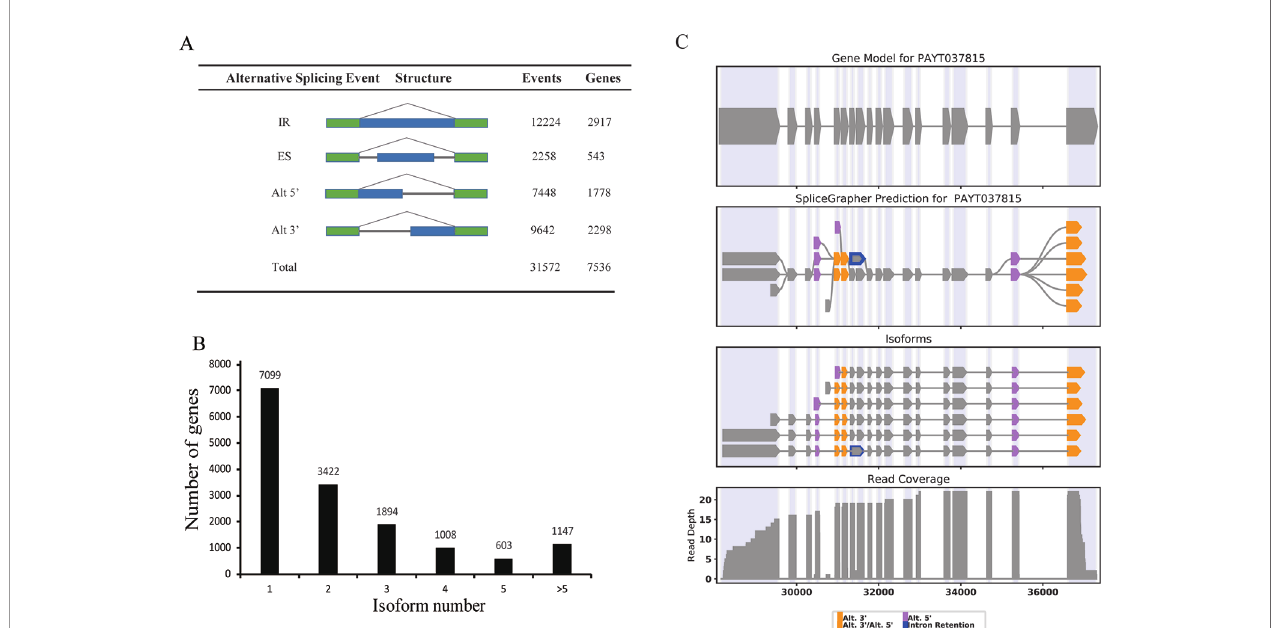
FIGURE 4 | Alternative splicing and splice isoform analysis with Iso-Seq reads. (A) The total number of AS events in genes based on Iso-Seq data. Alt 3', alternative 3' splicing; Alt 5', alternative 5' splicing; ES, exon skipping; IR, intron retention; Total, all AS events. (B) distribution of genes that produce one or more splice isoform. (C) An example of a gene that produces 6 novel splice isoforms. The gene models contain a single splice isoform for this gene. Gene model (top), splice graph (middle), and reads coverage (bottom) are